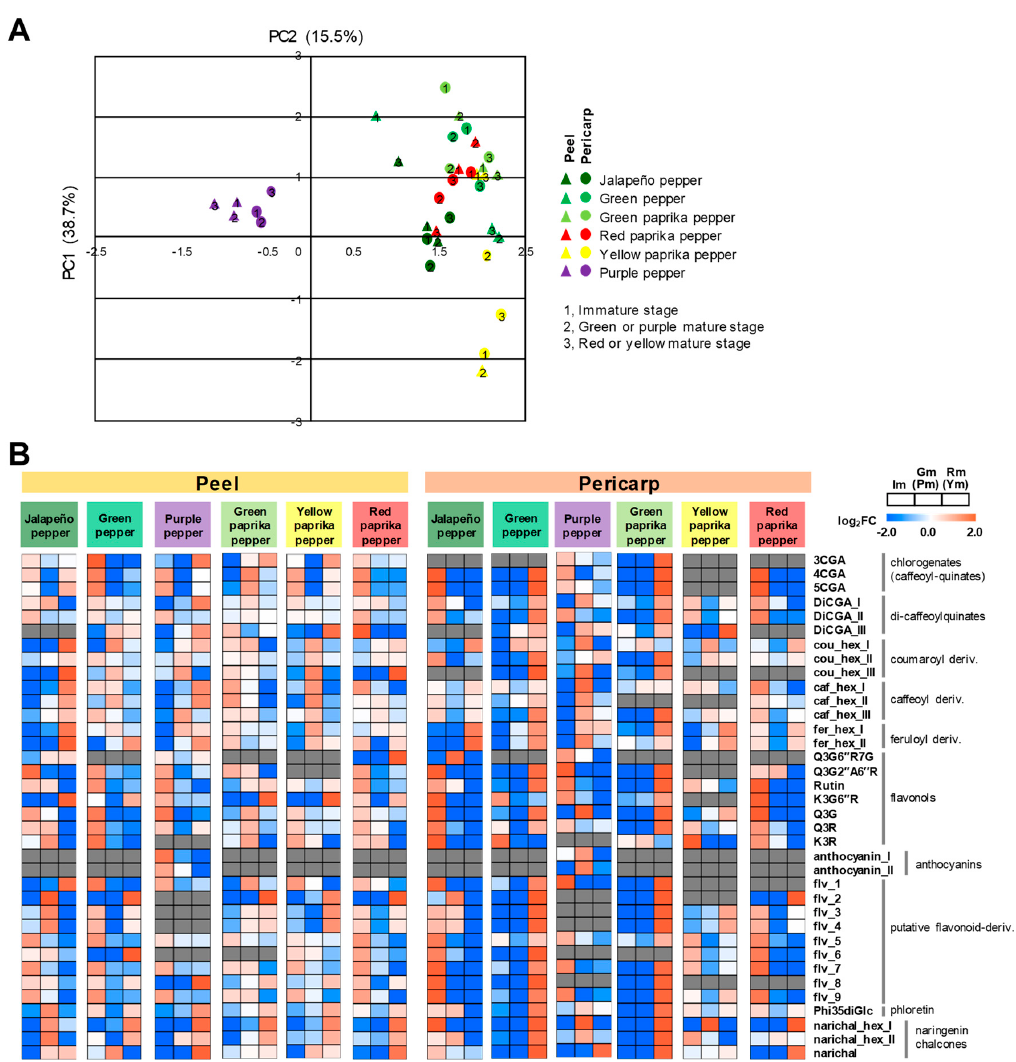
Figure 4. Metabolic shifts of polyphenolics in different fruit tissue among six pepper cultivars during fruit ripening . (A ) principal component analysis (PCA) of polyphenolics in different pepper cultivars during fruit ripening. The plots were applied for the 39 metabolites with the average values from 3 biological replications. PCA was conducted by the MultiExperiment Viewer [73]. Principal component (PC) triangles and circles indicate peel and pericarp, respectively. Coefficient correlation was estimated by person correlation method using MeV software. ( B ) heatmap visualization of metabolite data is normalized and scaled by log 2 FC (mean/average_mean) for each metabolite. Abbreviations: cou, coumaroyl; caf, caffeoyl; fer, feruloyl; CGA, chlorogenate; DiCGA, dicaffeoyl-chlorogenate; Glc/G, glucose; Rha/R, rhamnose; Api/A, apiose; hex, hexose; Phi, phloretin; flv, putative flavonol-derivatives; Narichal, naringenin chalcone; Im, immature stage; Gm(Pm), green mature (or purple mature stage); and Rm(Ym), red mature (or yellow mature stage). In the pungent cultivar (jalapeño pepper) , most polyphenols were upregulated in the peel during both green mature (14 polyphenols) and final mature (14 polyphenols) stages. Meanwhile, most polyphenols were upregulated in the pericarp during its immature stage (24 polyphenols). More hydroxycinnamates were upregulated in the peel (9) than in the pericarp (4) during its red mature stage. An elevation of eight hydroxycinnamates, namely coumaroyl-hexosides (cou_hex I, II, III), caffeoyl-hexosides (caff_hex I, II, III), and feruloyl-hexosides (feru_hex I and II), as well as a reduction of almost all flavonoids except rutin and putative flavonoid one (flv_1), were suggested as candidate